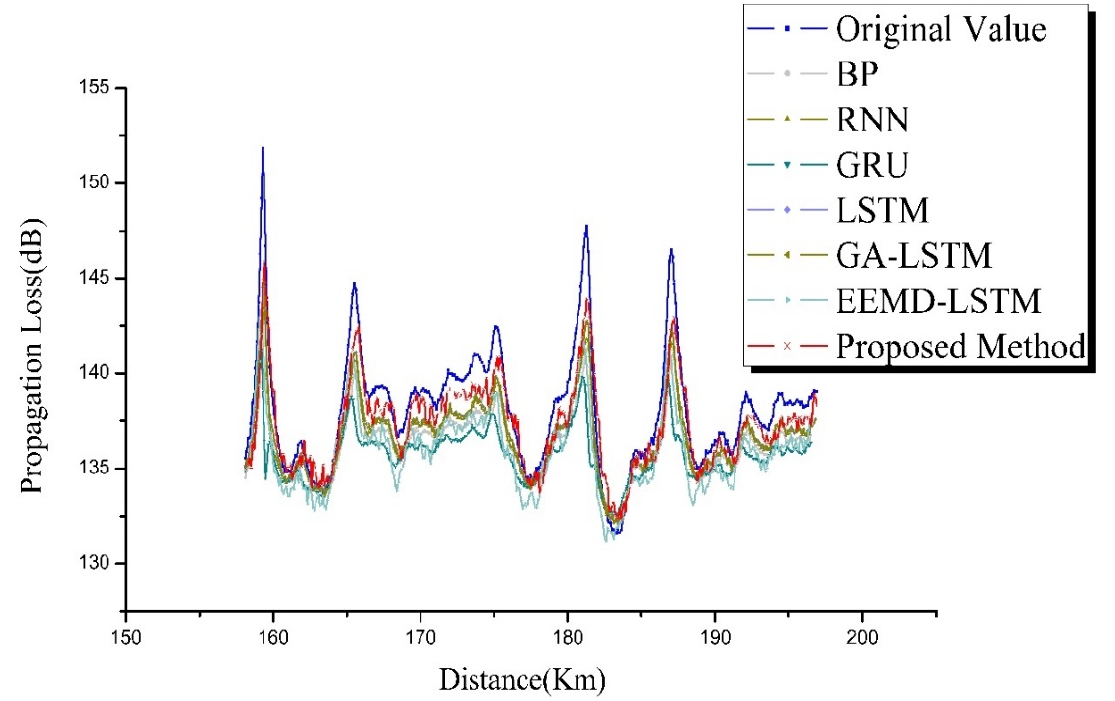
Figure 7. Comparison result of prediction performance of all prediction approaches (evaporation duct).